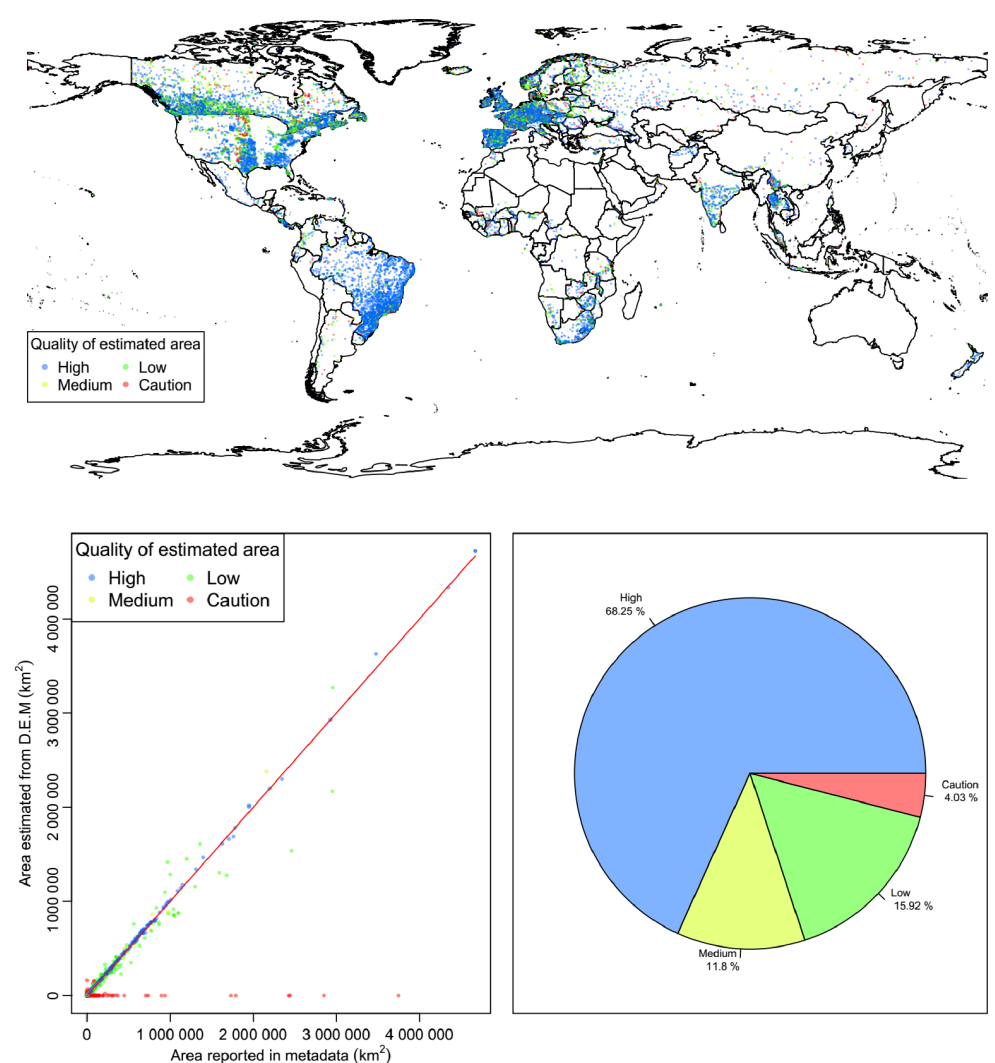
Figure 6. Quality of the delineated catchment boundary according to the categories of high, medium, low, and caution identified in Sect. 4.2 (for 18785 stations that have reported drainage area and reasonable geographical